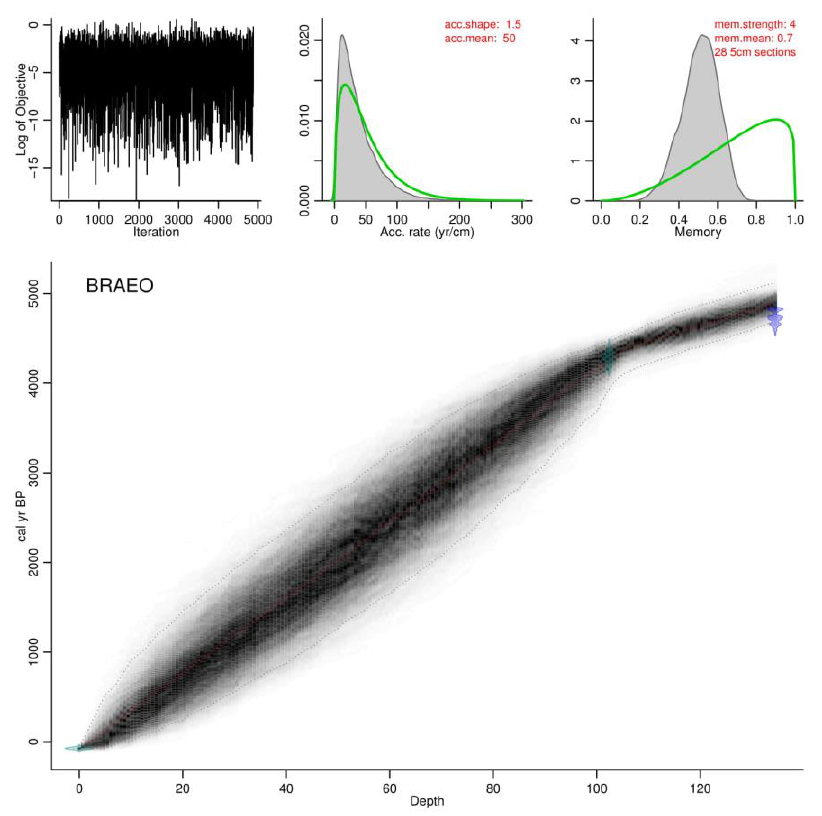
Figure A3d. Age-depth model produced in BACON for